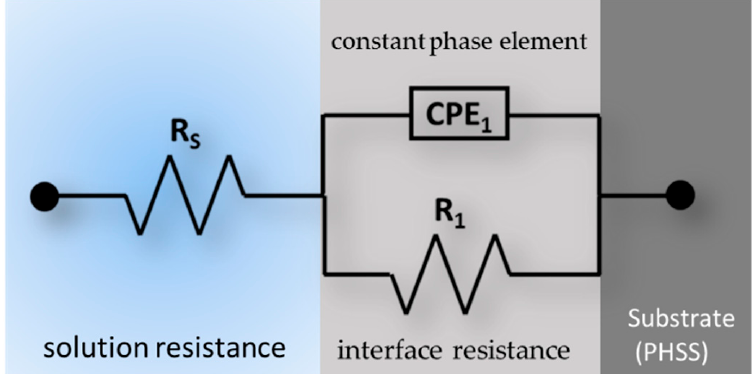
Figure 7. The proposed electrical equivalent circuit (EEC) model.